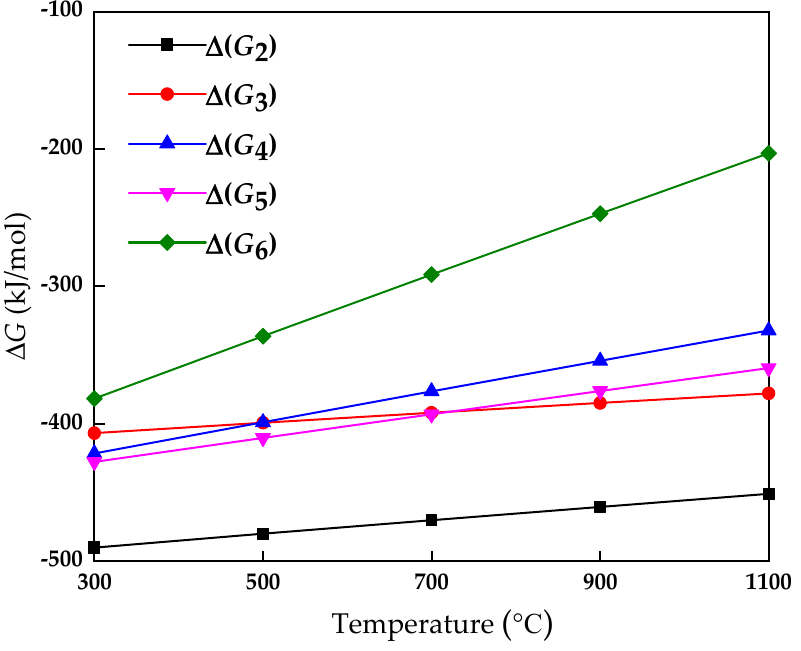
Figure 9. ∆ G changes with temperature. Figure 9. Δ G changes with temperature.